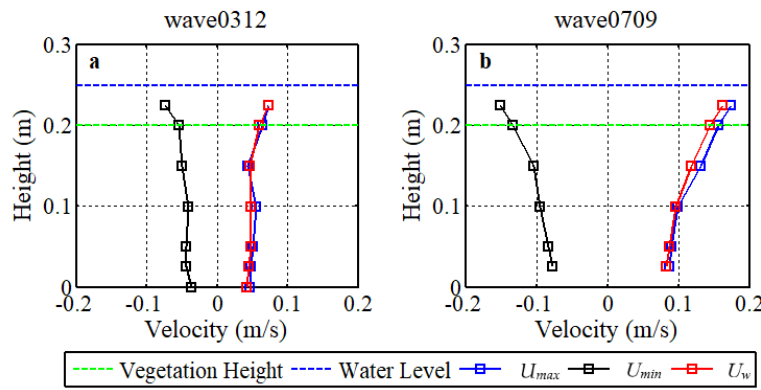
Figure 3. ( a ) Measured velocity profile for case wave0312 with 3 cm wave height and 1.2 s wave period, U min is the highest wave orbital velocity in negative direction (oppose to wave propagation), U max is the highest wave orbital velocity in positive direction (same as wave propagation), and U w is the amplitude of wave orbital velocity; ( b ) Measured velocity profile for case wave0709 with 7 cm wave height and 0.9 s wave period.